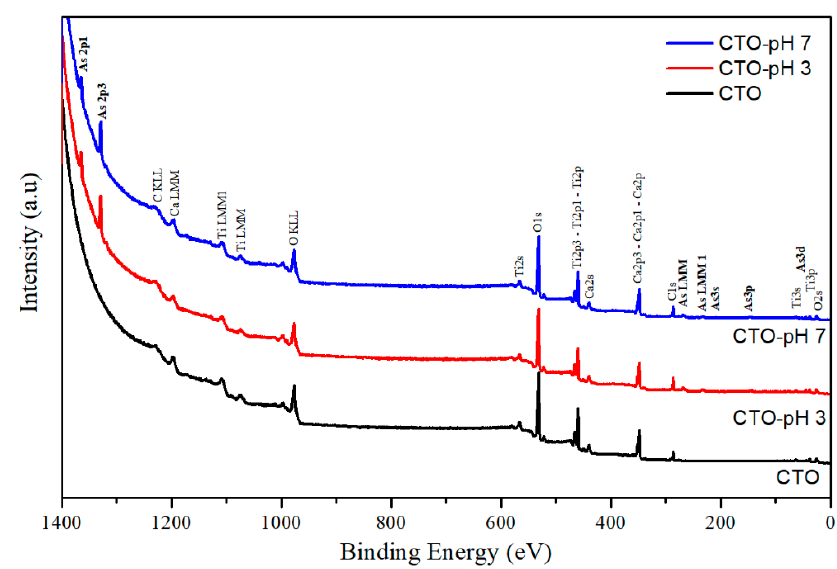
Figure 13. XPS survey spectra of samples before and after adsorption experiments at pH 3 and 7.